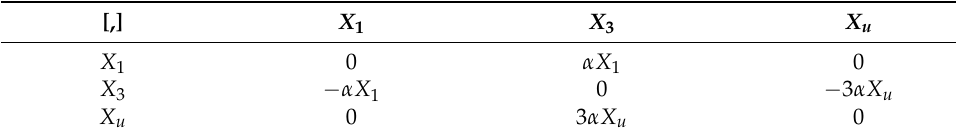
Table 3. Lie brackets for Case 2.